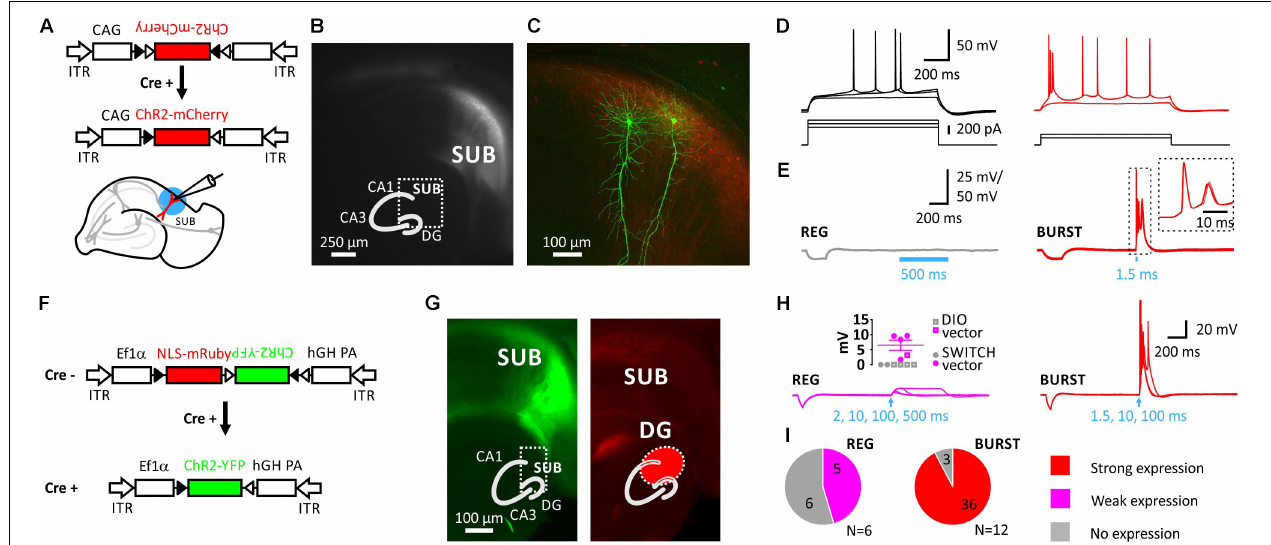
FIGURE 1 | Selective expression of Cre-dependent ChR2 in subicular burst-firing neurons in VGLUT2-Cre mice. (A) , Injection of AAVs into the subiculum (SUB) of VGLUT2-Cre mice. Schematic showing the Cre-conditional DIO-ChR2-mCherry construct and the slice preparation. Blue circle illustrates blue light illumination. (B) , Live image of mCherry fluorescence showing mCherry-positive neurons in the SUB. Inset shows schematic of hippocampus with DG, CA3, CA1, and SUB. (C) , Maximum projection of confocal z-stacks of biocytin-filled neurons and virally induced expression of the red fluorophore. (D) , Firing pattern of a subicular regular-firing (REG, left), and of a subicular burst-firing neuron (BURST, right). (E) , Left: Average of 10 traces using a 500 ms light pulse demonstrated no expression of ChR2 in REG neuron. Right: In contrast, a 1.5 ms light pulse elicited action-potential firing in subicular BURST neuron; inset shows 10 consecutive traces. Recordings were performed in the presence of blockers of synaptic transmission. (F) , Switch vector design allowing NLS-mRuby expression in Cre-negative and ChR2-YFP expression in Cre-positive neurons. (G) , Left: EYFP signal is restricted to SUB, whereas NLS-mRuby is seen in the distal CA1 region, SUB and the DG (on the right). Infected area indicated in red in inset. (H) , Left: Blue-light stimulation of up to 500 ms (indicated by arrow) elicited no or small depolarizations of < 10 mV due to no or weak expression of ChR2 in regular-firing (REG) neurons. Inset shows evoked depolarization ( n = 5; N = 3 mice). Closed circles indicate mice infected with Switch vector, color code as in (I) . Right: Strong expression of ChR2 resulted in action-potential firing in BURST neurons ( n = 36 out of 39 neurons; N = 12 mice). (I) , None of the REG neurons showed strong expression of ChR2, which means none fired APs ( n = 11 neurons; N = 6 mice), in contrast to 36 out of 39 BURST neurons showing light-induced AP-firing ( N = 12 mice). Data pooled from both Cre-conditional